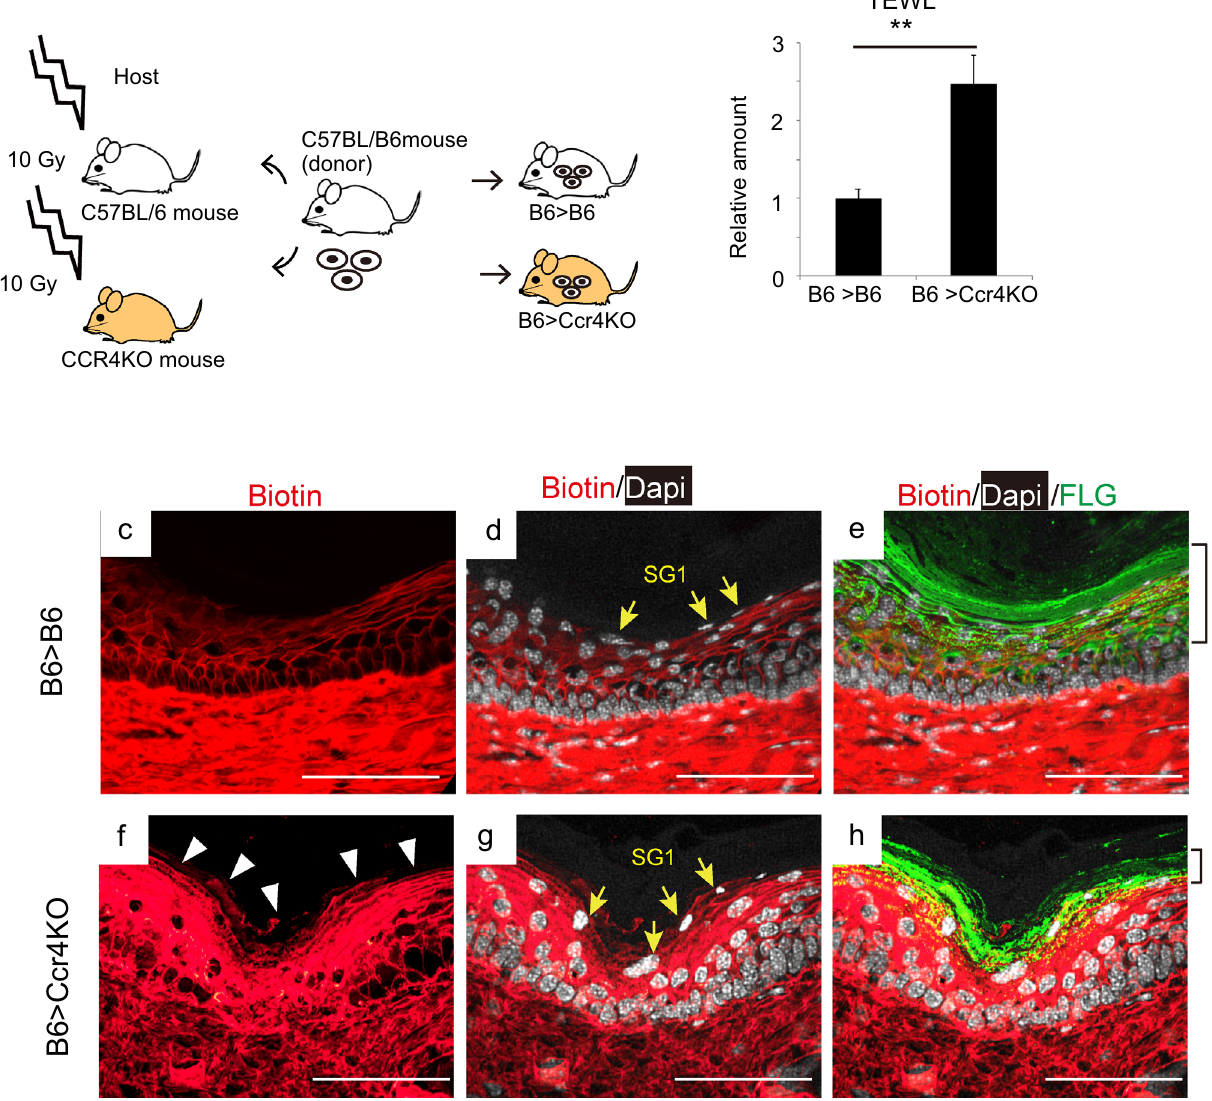
Figure 5. Ccr4 deletion in the skin causes skin barrier dysfunction in mice. ( a ) Experimental design for CCR4-KO in the skin. ( b ) TEWL of B6 > CCR4 KO significantly increased compared to that of B6 > B6 2.5 months after BMT. ** P < 0.01. n = 6 for each. ( c – h ) Biotin function assay was performed 2.5 months after BMT. Reticular patterns of biotin-positive granular layers were observed in B6 > B6, while they were destroyed, and biotin stain surrounded SG1 in B6 > CCR4 KO mice. Yellow arrows indicate SG1, while brackets show the filaggrin-positive layers. Scale bars, 50 µm. The experiments were repeated twice. TEWL, transepidermal water loss; BMT, bone marrow transplantation; KO, knockout; SG1, granular layer 1 of mouse